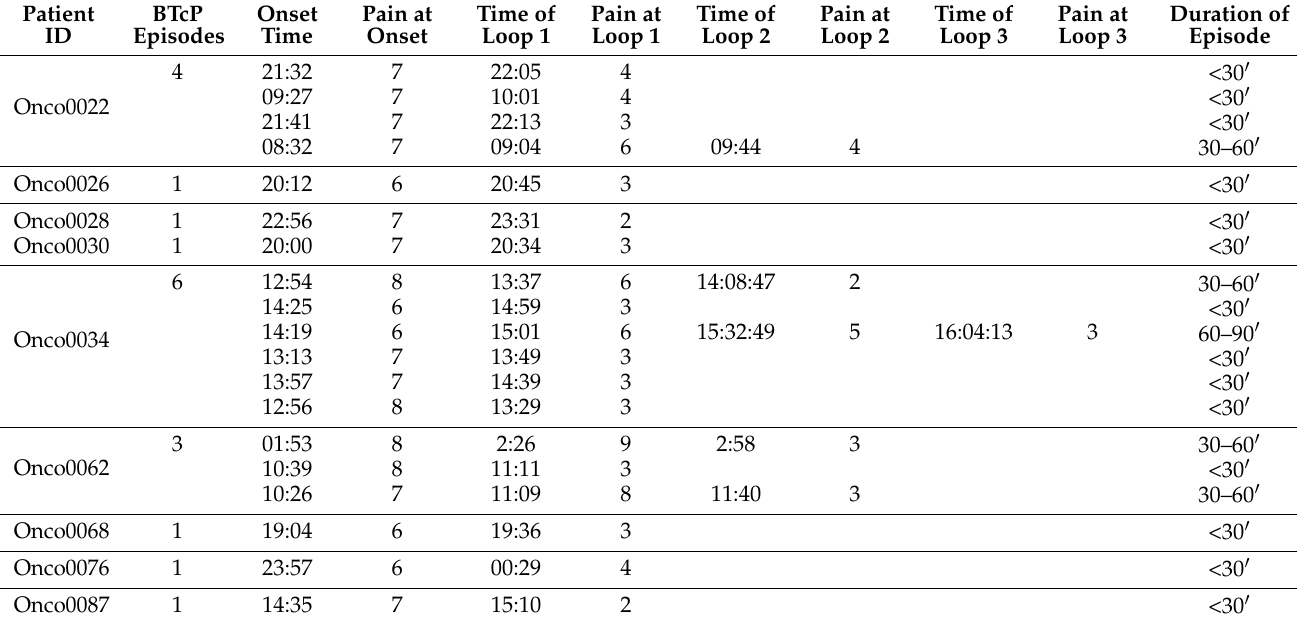
Table 2. Description of breakthrough pain